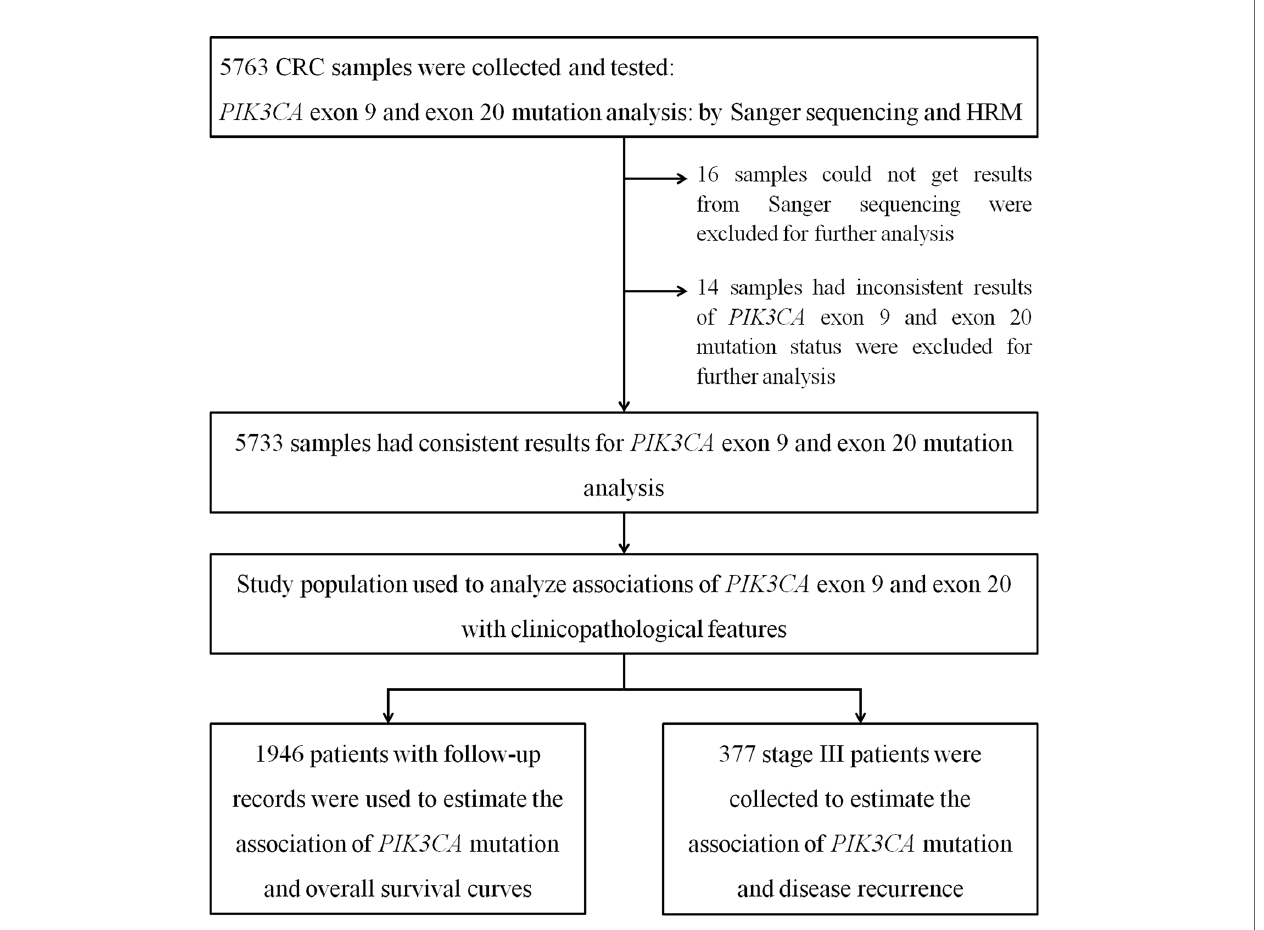
FIGURE 1 | Selection of study